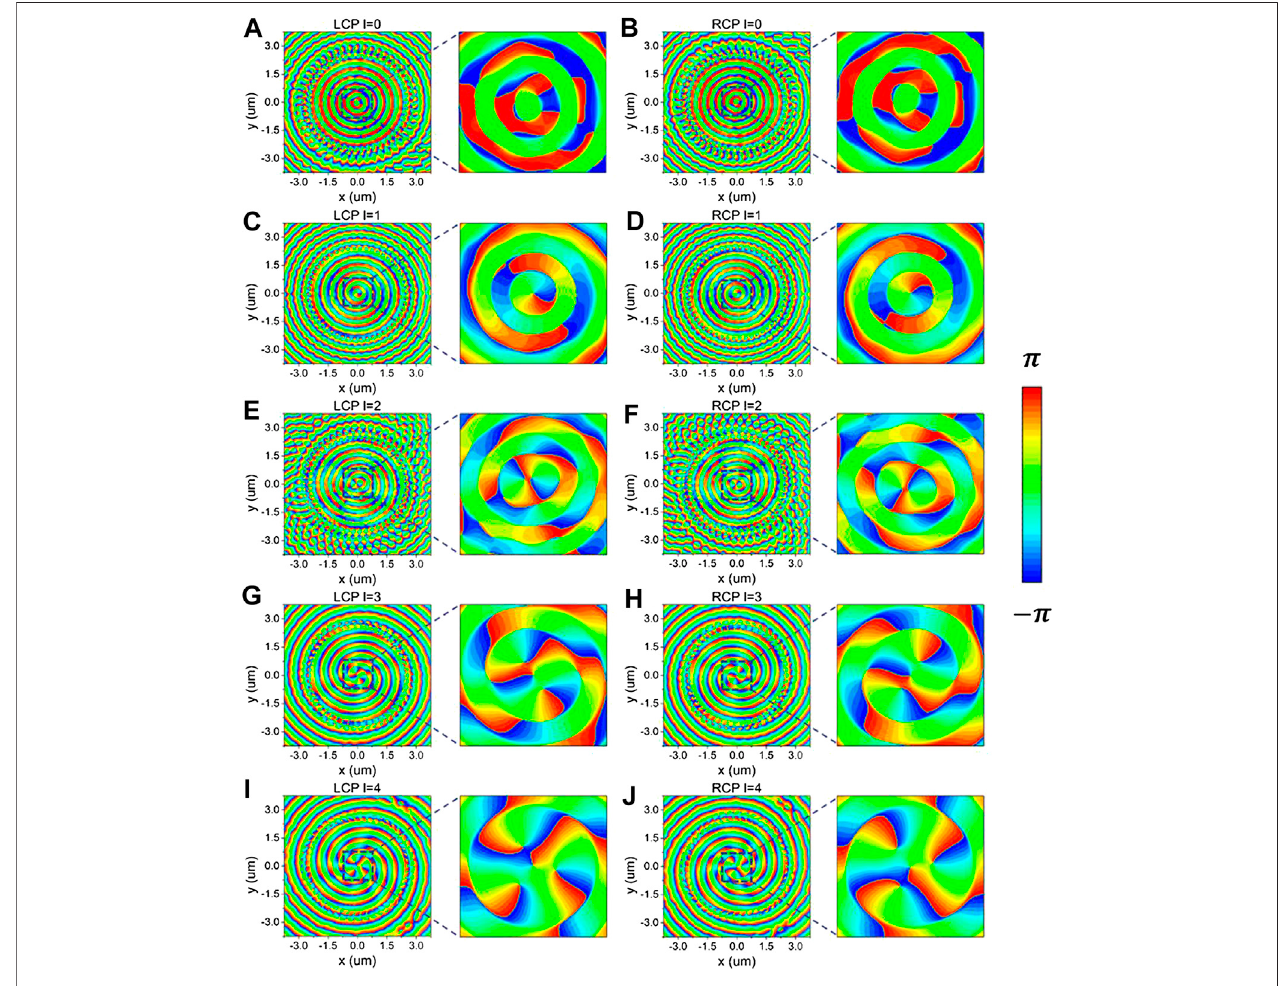
FIGURE4| WhentheincidentisLCP,the E z - fi eldphasedistributiononthePVgeneratoriscalculatedandthetopologicalchargesare0 (A) ,1 (C) ,2 (E) ,3 (G) ,and 4 (I) , respectively. And the E z - fi eld phase distribution of the PV generator are shown in (B) , (D) , (F) , (H) , and (J) when the incident is RCP.